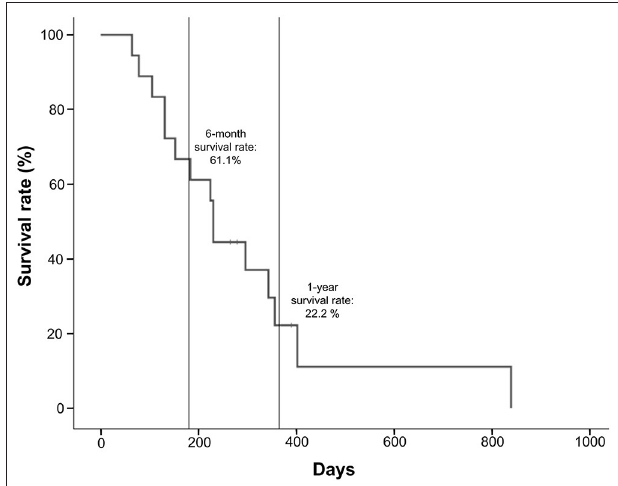
FIGURE 3 | Survival rates of anaplastic thyroid cancer patients treated with lenvatinib.